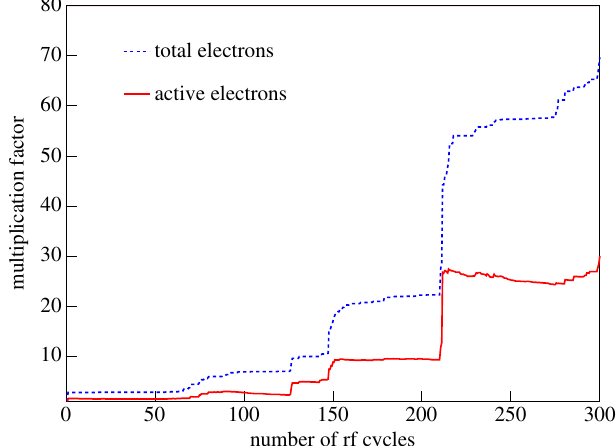
FIG. 19. (Color) Multiplication factor as a function of time over 300 rf cycles while the rf field decays from 0 : 6 MV = m to about 0 : 55 MV = m . The solenoid currents are 400 A for the main solenoid and 30.5 A for the bucking solenoid.